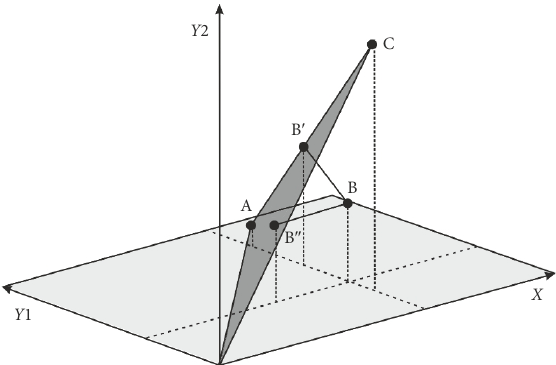
Fig. 4. Production frontier – a case of two outputs and a single input